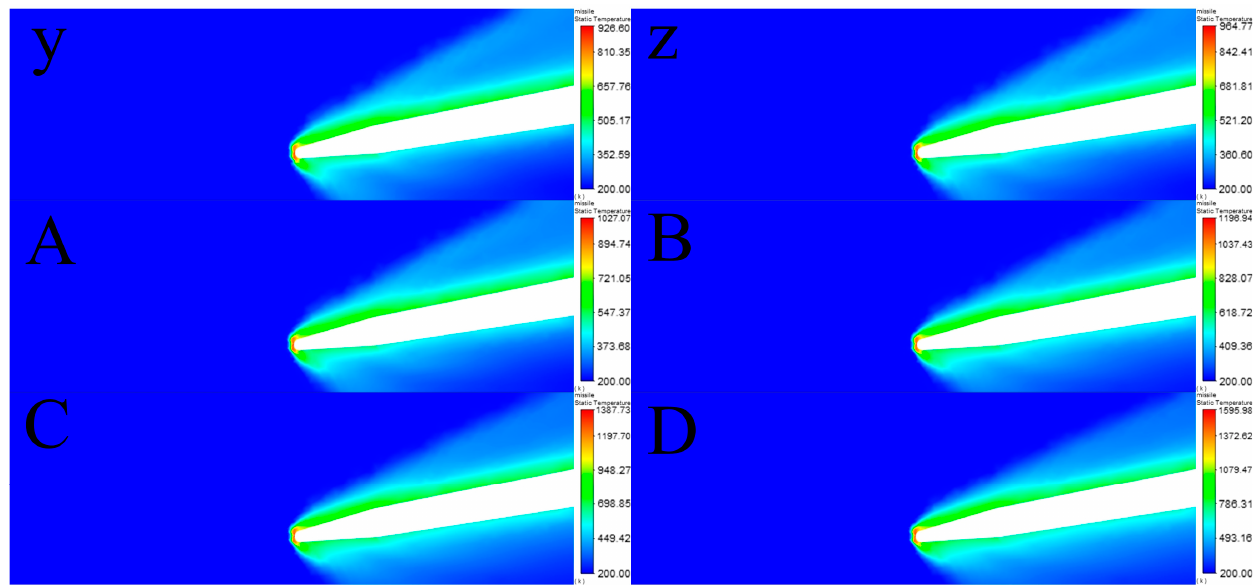
Figure 6. The contours of groups ( y – D ) with attack angle 10°.